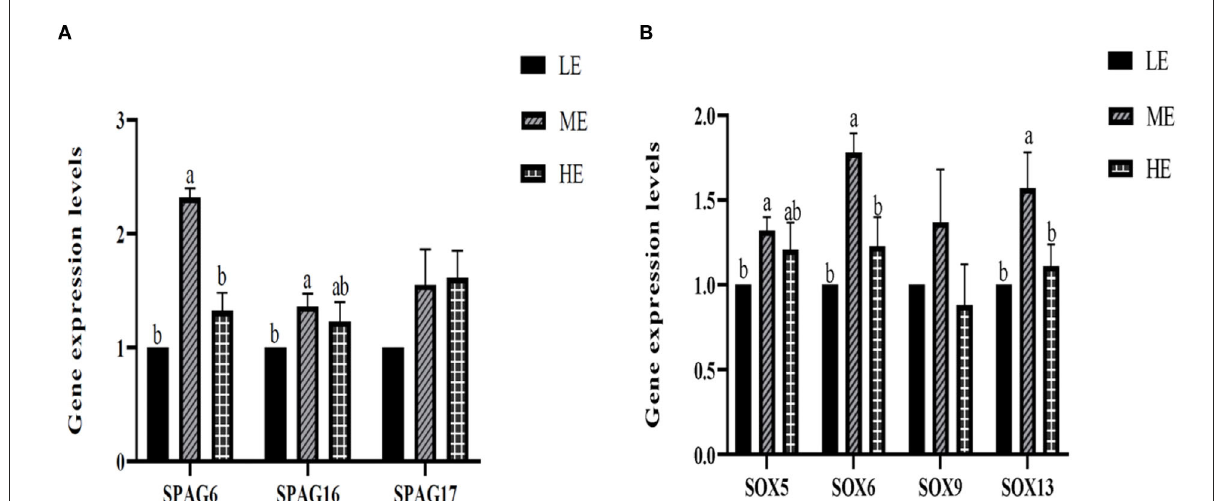
FIGURE3 Effects of differential energy treatment on the expression of sperm motility-related genes. (A) Effects of differential energy treatment on the expression of the SPAG gene family. (B) Effects of differential energy treatment on the expression of the SOX gene family. LE, Low energy level; ME, Moderate energy level; HE, High energy level.